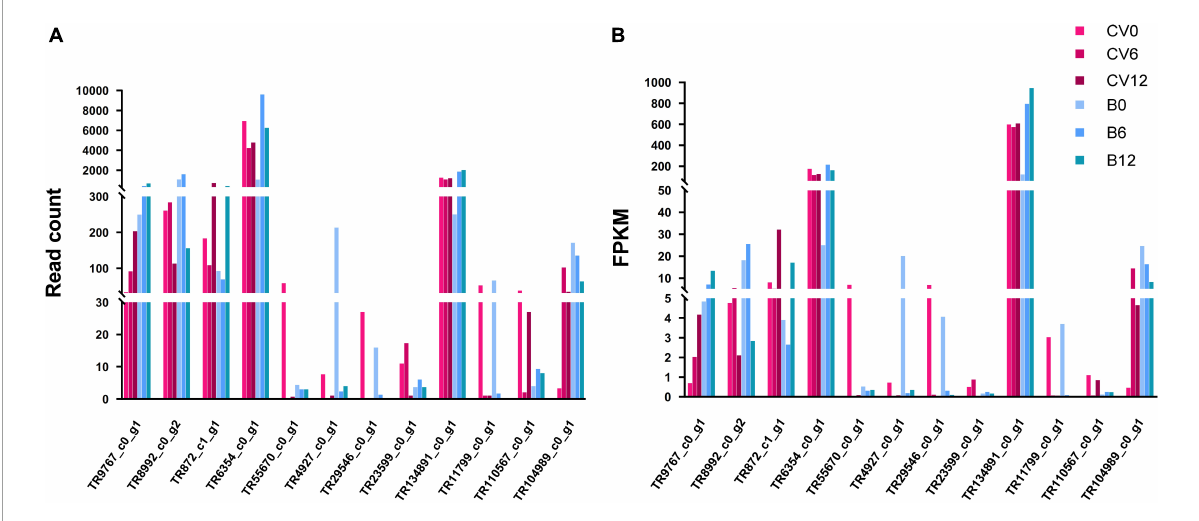
FIGURE7 Changes in the (A) read counts and (B) expression levels of 12 highly responsive transcription factors at early stage of CLCuMuV infection of whiteflies (Asia II 7 and MEAM1).